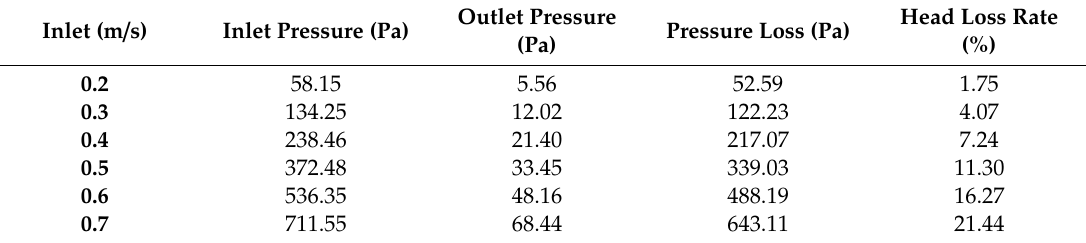
Table 3. CFD-simulated changes in both pressure and head with di ff erent inlet velocities. Inlet (m / s) Inlet Pressure